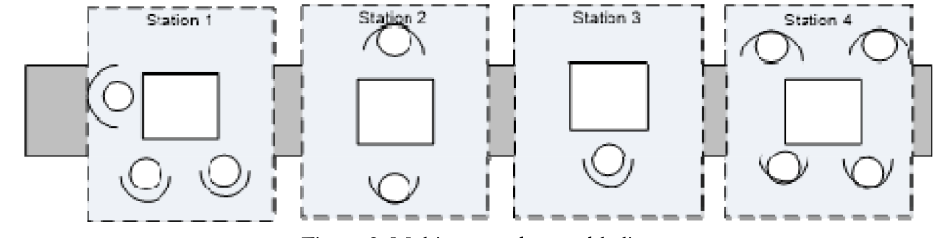
Figure 2. Multi-manned assembly